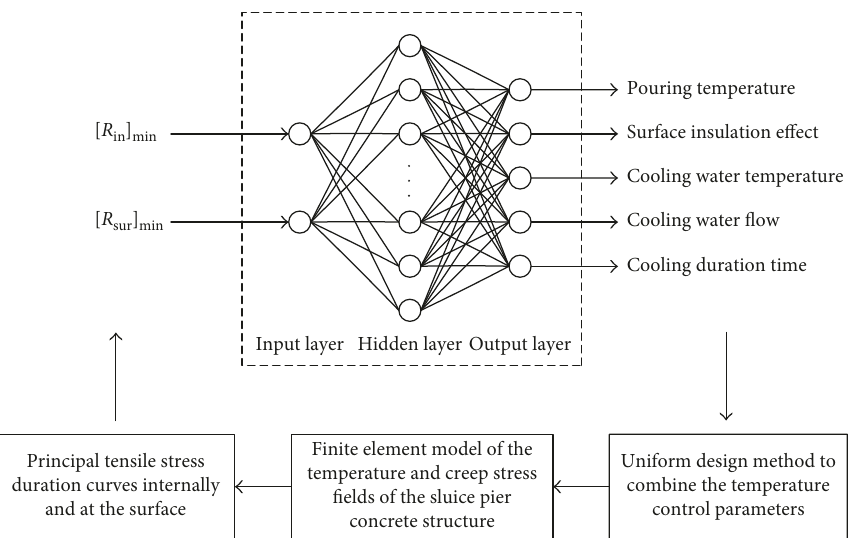
Figure 1: Neural network optimization model based on the uniform design method.